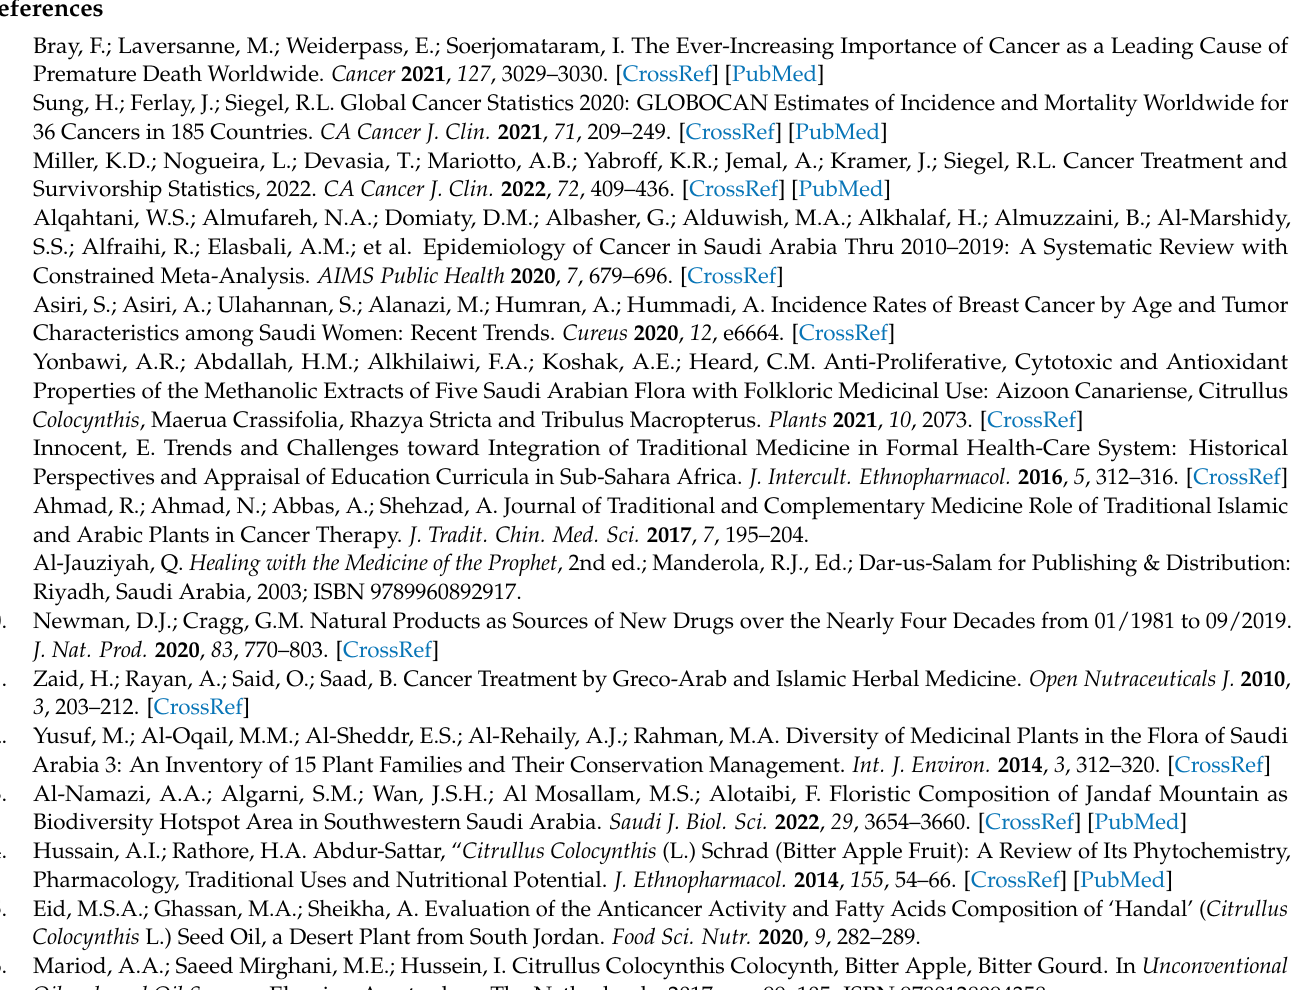
Figure S3. Cytotoxic activity C. colocynthis on Breast cancer MCF-7 cell line. Figure S4. Calibration curve for standard gallic acid. Figure S5. GC chromatogram and mass spectra of methanol extract of C. colocynthis